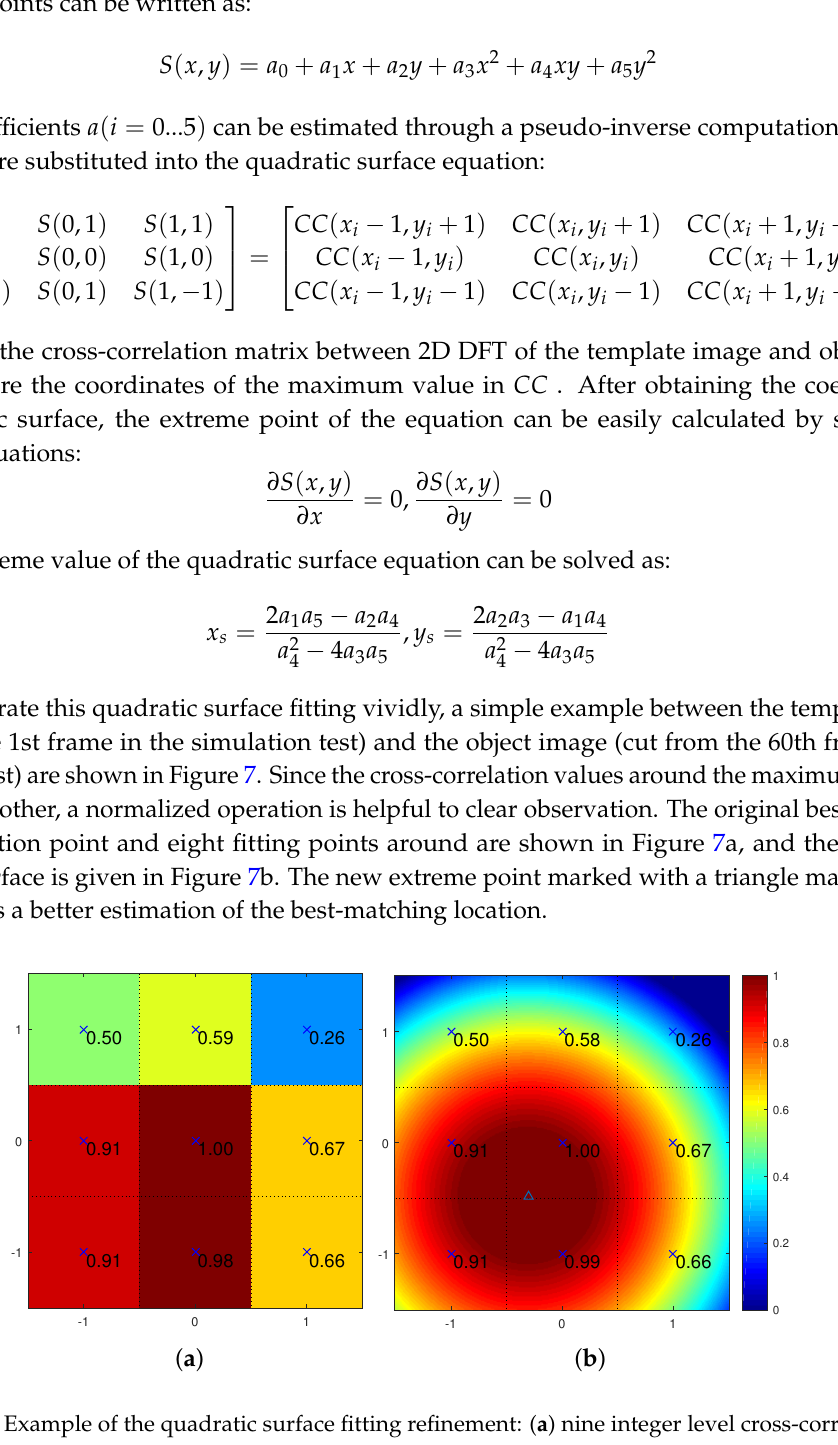
Figure 7. Example of the quadratic surface fitting refinement: ( a ) nine integer level cross-correlation values for curve fitting; ( b ) the fitting quandratic surface, and the triangle marker is the refined subpixel estimation of the best-matching